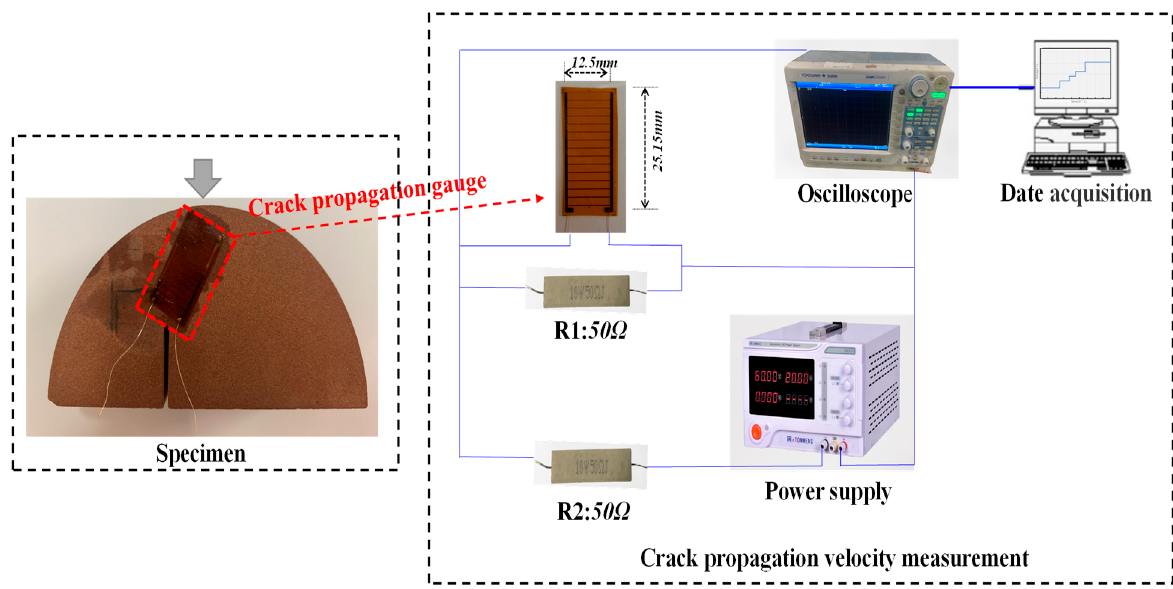
Figure 4. Schematic of crack propagation rate measurement.